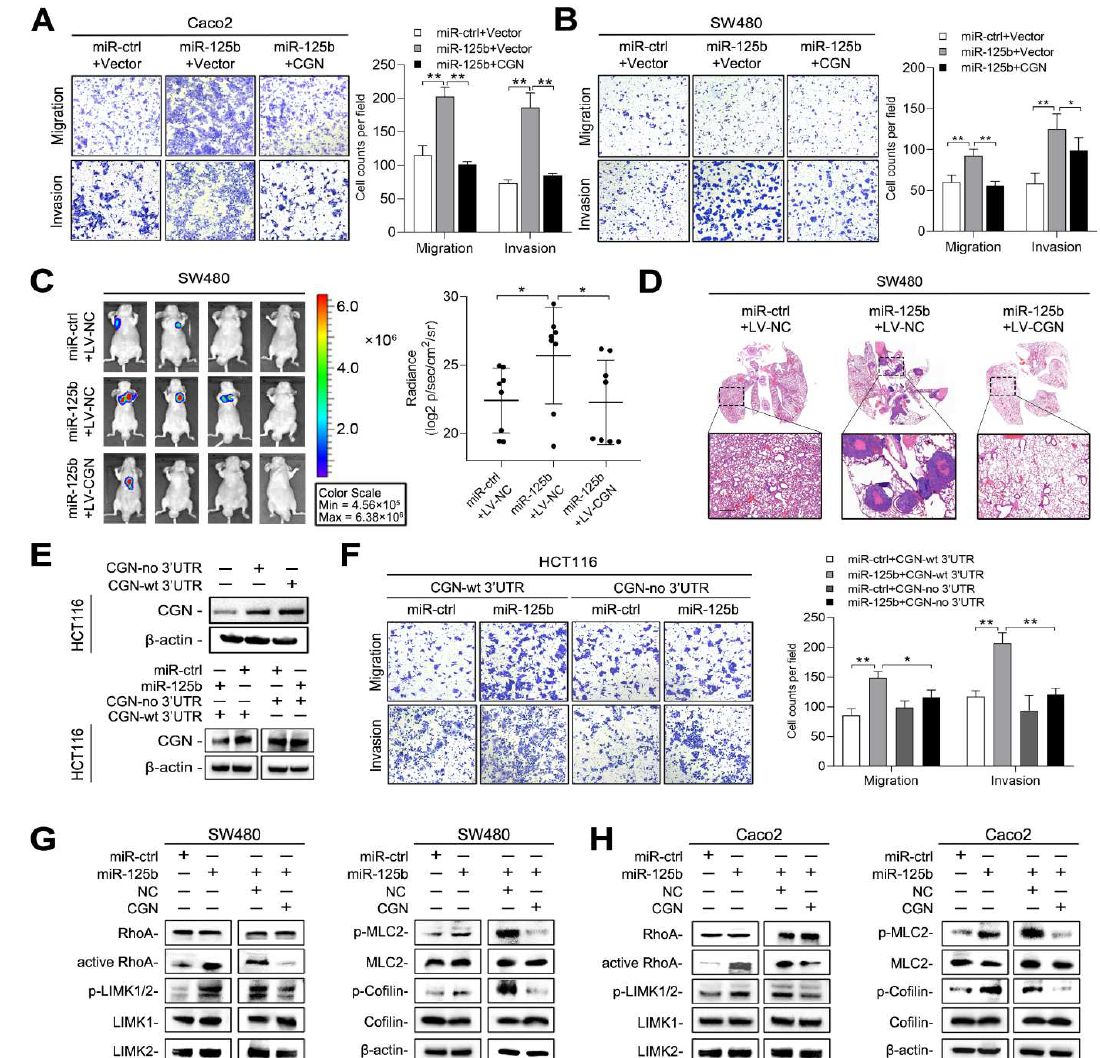
Figure 7. miR-125b activates Ras Homolog Family Member A (RhoA)/Rho Kinase (ROCK) signaling by targeting CGN. ( A , B ) Transwell assays of Caco2 ( A ) and SW480 ( B ) cells transfected with miR-125b or miR-ctrl and the CGN plasmid or control vector. ( C ) Bioluminescent images and radiance values of mice ( n = 8) injected with SW480 cells after the indicated transduction. ( D ) Representative H&E staining images of lung tissue sections from the indicated groups. Scale bars represent 500 µ m. ( E ) CGN plasmid containing either with or without 3 (cid:48) UTR was transfected into HCT116 cells, and western blotting was performed 48 h after transfection (upper). HCT116 cells were transfected with CGN plasmid containing wild-type 3 (cid:48) UTR or lacking 3 (cid:48) UTR along with miR-125b or vector control (lower). ( F ) Migration and invasion assays of HCT116 cells transfected with the CGN expression plasmid with or without 3 (cid:48) UTR along with miR-125b or miR-ctrl. ( G , H ) Western blotting analysis of proteins in RhoA/ROCK pathway in SW480 ( G ) and Caco2 ( H ) cells after indicated transduction. * p < 0.05, ** p < 0.01 by one-way ANOVA followed by Dunnett’s multiple